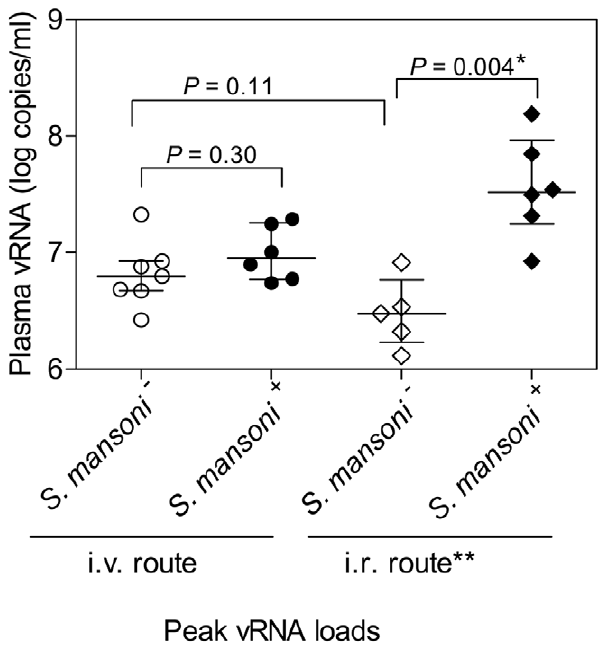
Figure 2. Peak viral RNA loads . Peak viral RNA loads were compared between parasite-free and S. mansoni -infected RM in i.v and i.r. challenge experiments. *, P = 0.004 was statistically significant after the Bonferroni correction (since it was below 0.017). **, previously published data were used for comparison [13]; those studies had been performed with the identical stock of SHIV-1157ipd3N4 used